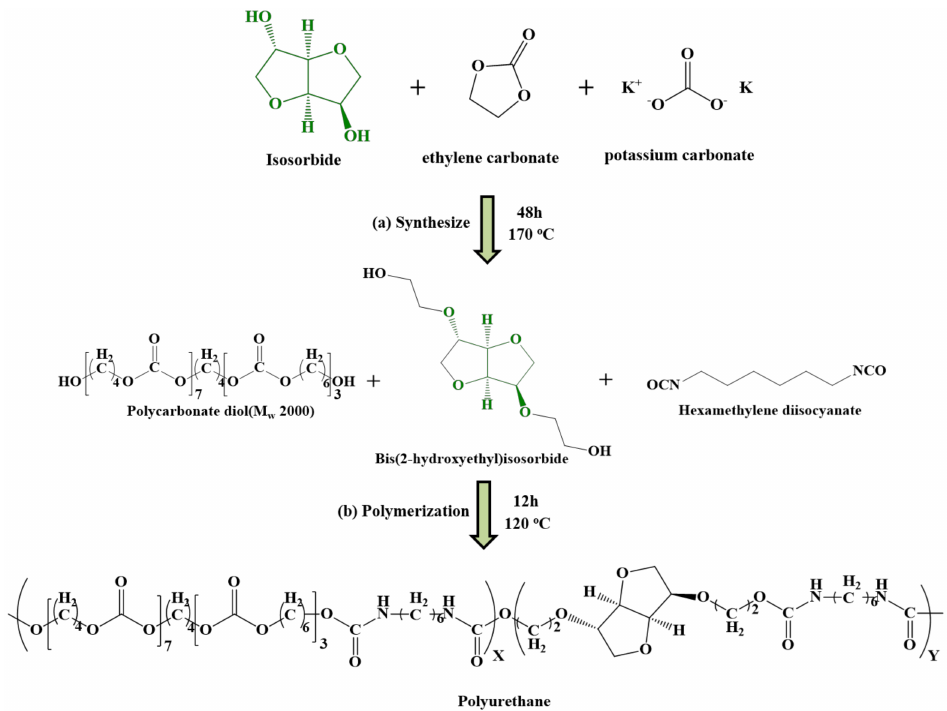
Figure 1. ( a ) Synthetic scheme of BHIS, ( b ) polyurethane structure synthesized with PCD, BHIS, and